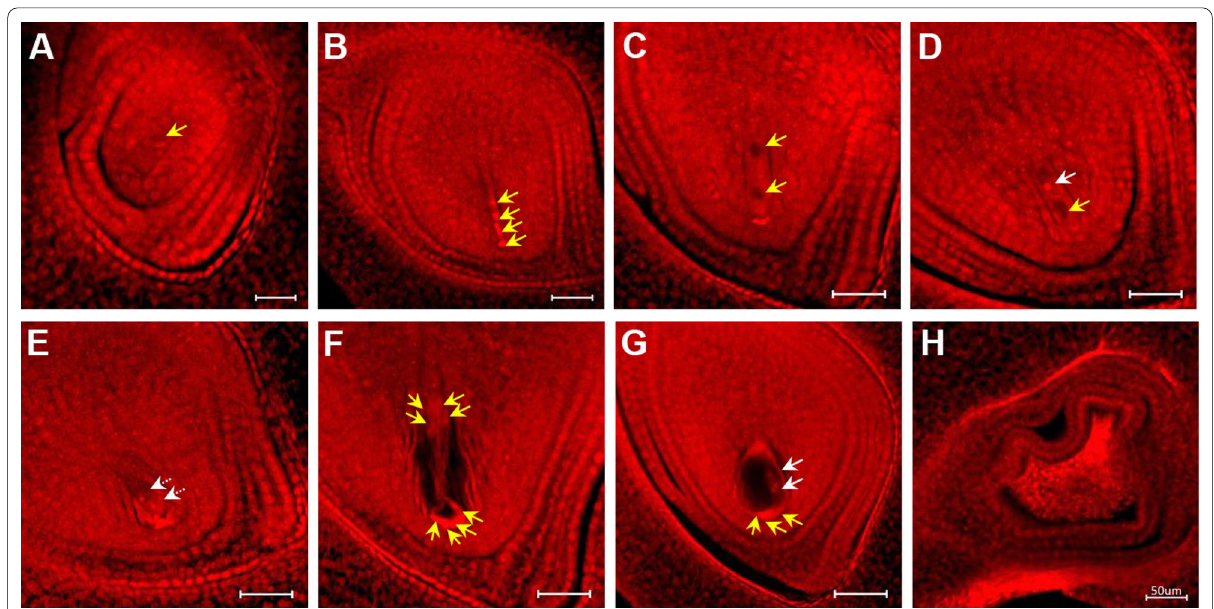
Fig. 3 Different types of abnormalities that occurred during embryo sac development in IR64 exposed to six days of heat stresses (38 °C—HT38; 40 °C—HT40) during gametogenesis. ( A ) Degenerated megaspore mother cell (yellow arrow indicates the missing nuclei); ( B ) All four megaspores degenerated, indicated by yellow arrows; ( C ) Abnormal two‑nucleate embryo sac, with both nuclei degenerated (yellow arrows); ( D ) Abnormal two‑nucleate embryo sac with one nucleus degenerated (yellow arrow), white arrow shows the remaining one active nucleus. ( E ) Abnormal two‑nucleate embryo sac without a large vacuole and both nuclei located at the micropylar region (Two nuclei indicated by white arrows were supposed to be located one each at micropylar and chalaza end, similar to Figure 2E). ( F ) Abnormal eight‑nucleate embryo sac with missing nuclei (yellow arrows); ( G ) Abnormal eight‑nucleate embryo sac with degenerated egg apparatus (yellow arrows indicate the degenerated egg cell and synergids); white arrow indicates two active nuclei; and ( H ) Shrunken embryo